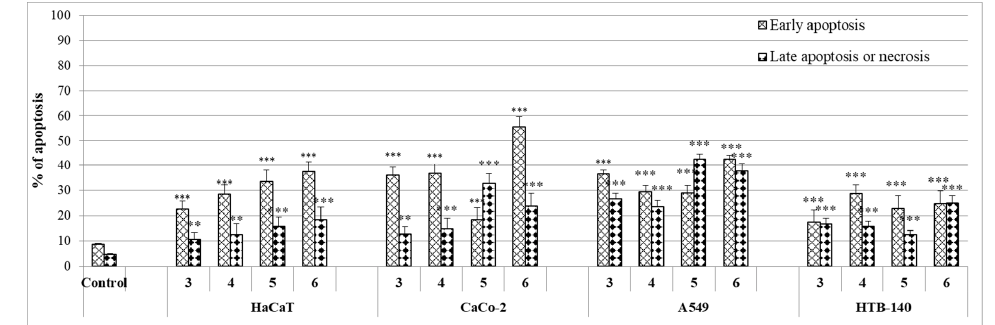
Figure 7. The effect of derivatives 3 – 6 on early and late apoptosis, or necrosis in HaCaT, CaCo-2, A549, and HTB-140 cells. Cells were incubated for 72 h with tested compounds and used in their IC 50 concentrations. Then cells were harvested, stained with Annexin V-FITC and 7-AAD, and analyzed using flow cytometry. Data are expressed as the percentage of cells at an early stage of apoptosis or late stage of apoptosis or necrosis. Data are given as means ± SD, *** p ≤ 0.001, ** p ≤ 0.01, as compared to the